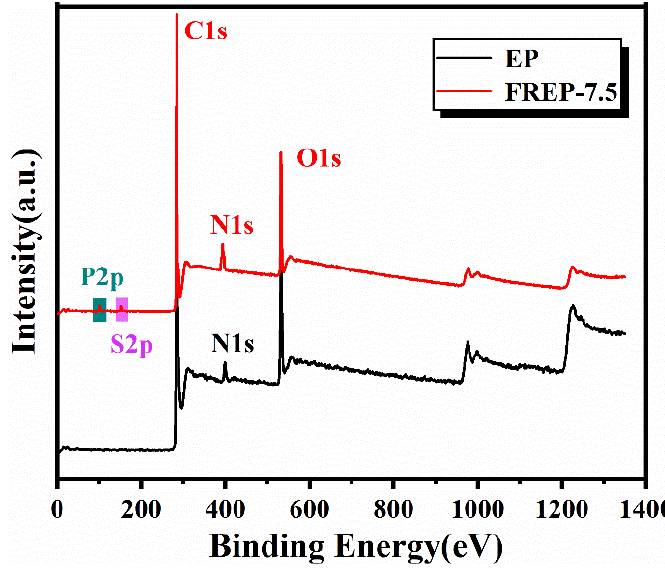
Figure 7. XPS total spectrum of residual char from EP and FREPs. Table 6. Composition and content of char residues.